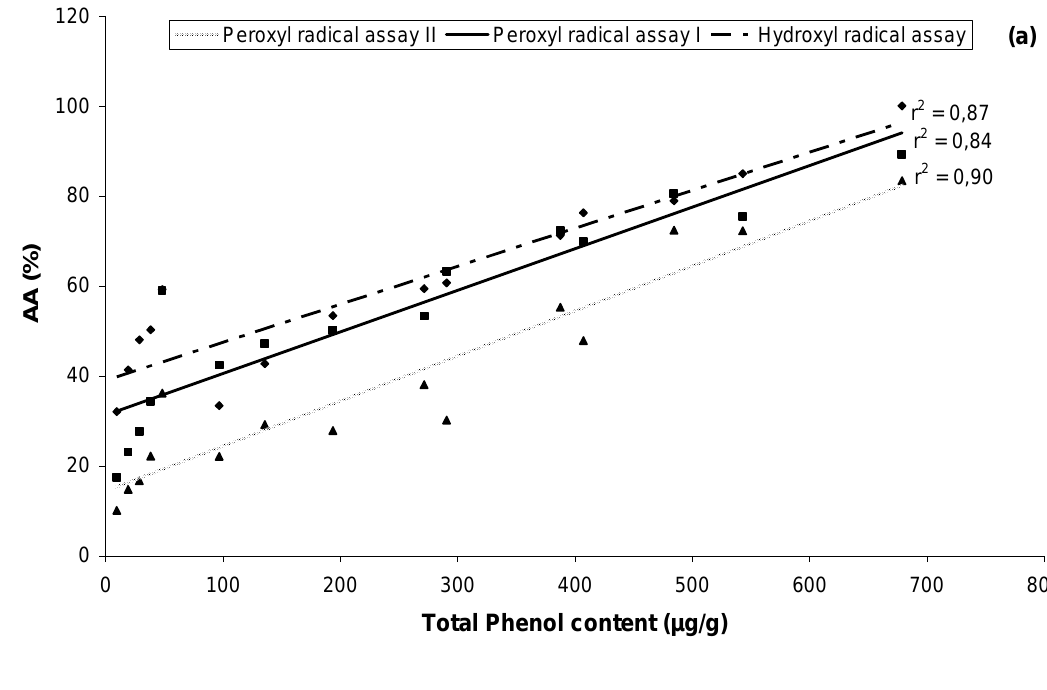
Figure 6. Relationship between radical scavenging activities and total phenolic content obtained by Folin-Ciocalteu (a) and HPLC method (b).